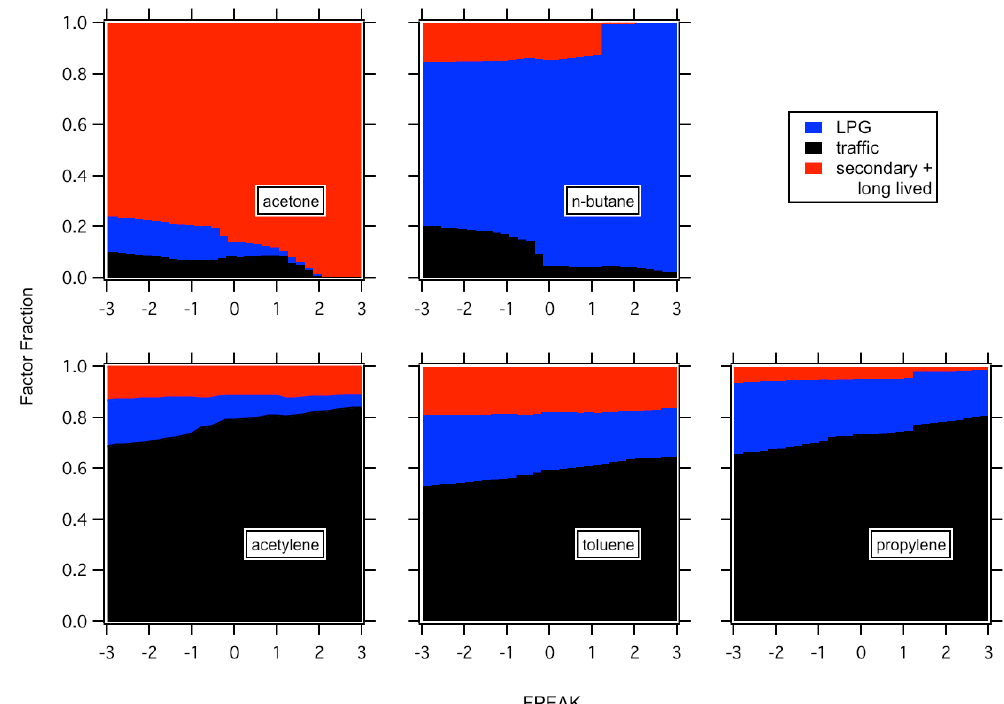
Figure 10. Variability in apportionment to factors as a function of the PMF rotational parameter FPEAK for acetone, n-butane and three hydrocarbons dominated by traffic emissions (acetylene, toluene and propylene). The change in the PMF quality of fit parameter is less than 2% for the FPEAK values shown.